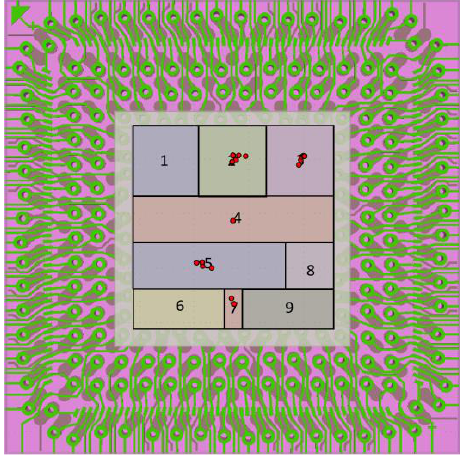
Figure 14. Localization of the maximal temperature reached by the chip during the transient simulation.